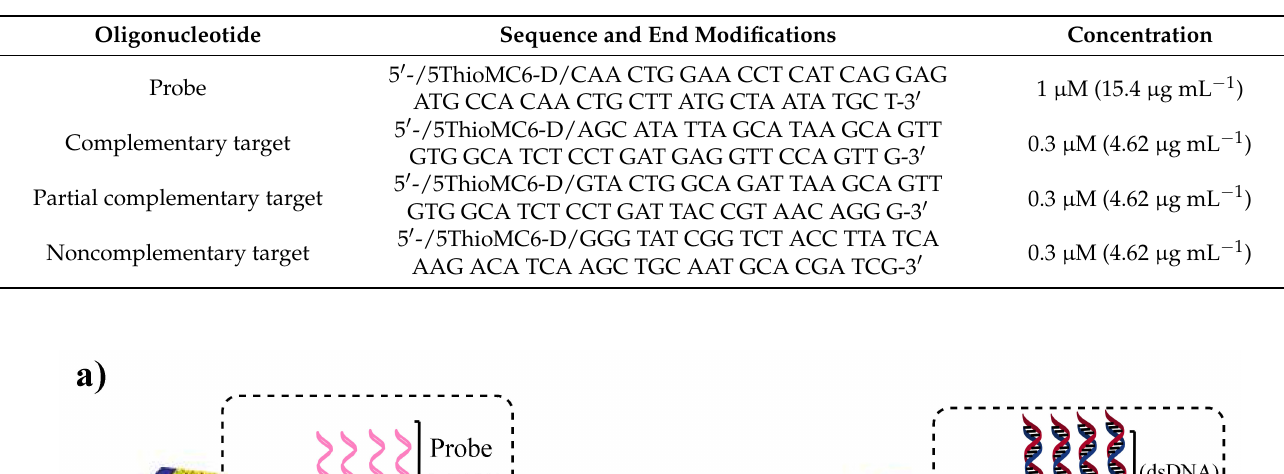
Table 1. Single-stranded DNA sequences used in this DNA hybridization study.